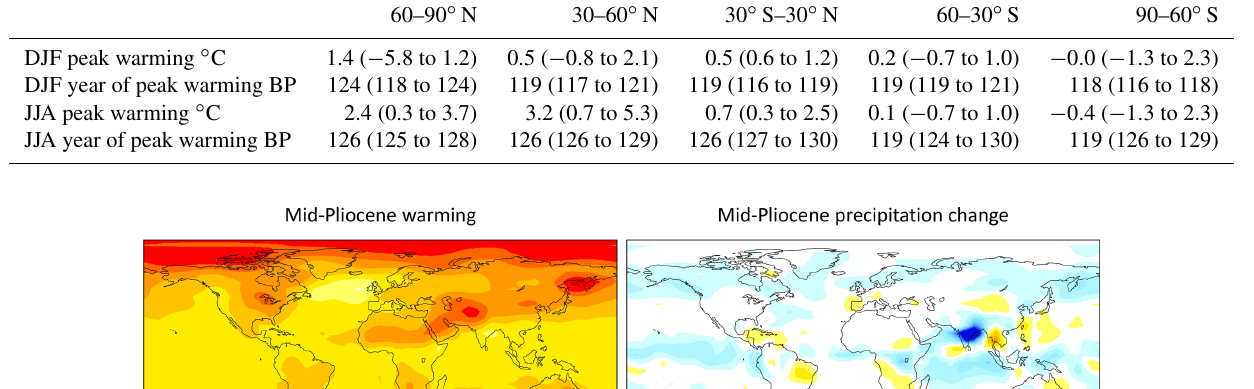
lated climate data E and the difference with observed clima- tology E 0 − C are illustrated in Fig.